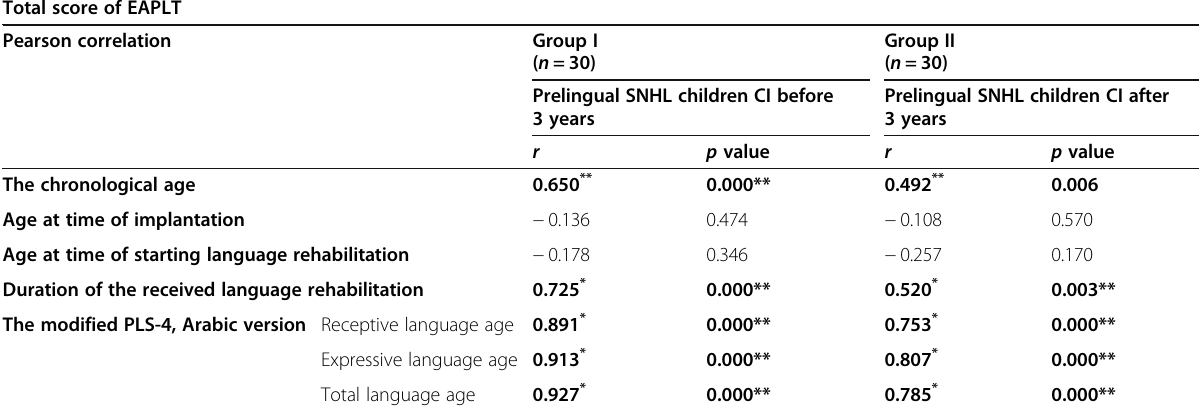
Table 7 Pearson Correlation between the total score of the Egyptian Arabic Pragmatic language test (EAPLT) and the chronological age, the age at time of CI, the duration of the received language rehabilitation and the scores of the modified PLS-4 (Arabic version) among the participated children in the 2 studied